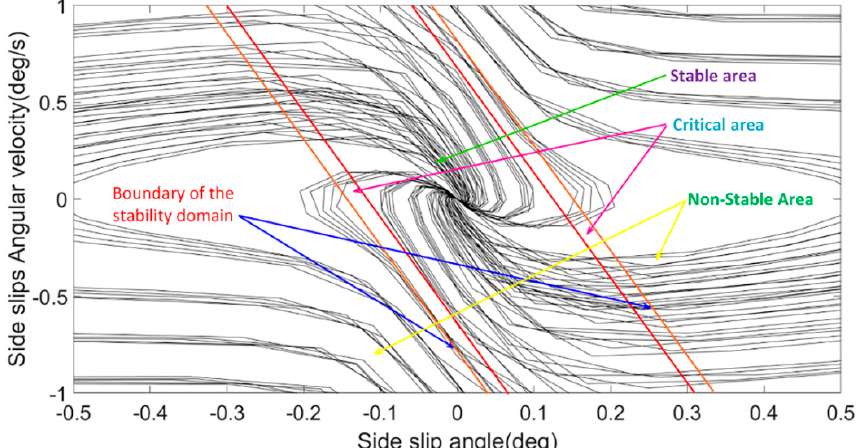
Figure 3. Further delineation of phase plane stability domain.